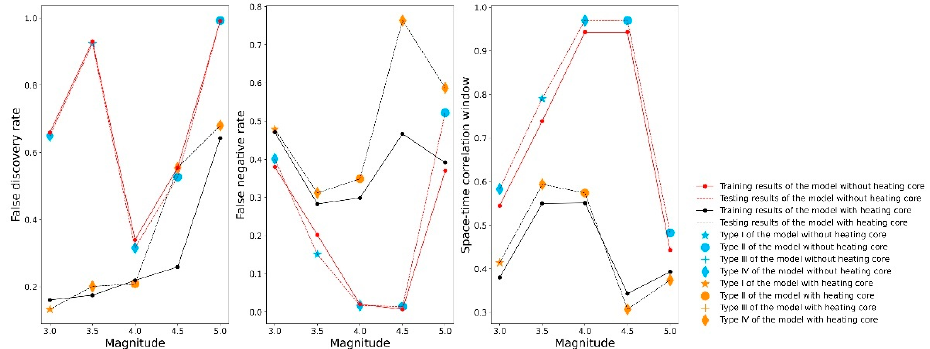
Figure 5. Comparison of the training and test results of the optimal model with and without a “heating core” at different magnitudes when the resampling scale is 50; the solid line and the dashed line represent the results of training and testing, respectively, while the blue and yellow marks represent the alarm types of the models without/with a “heating core”, respectively (the same below).